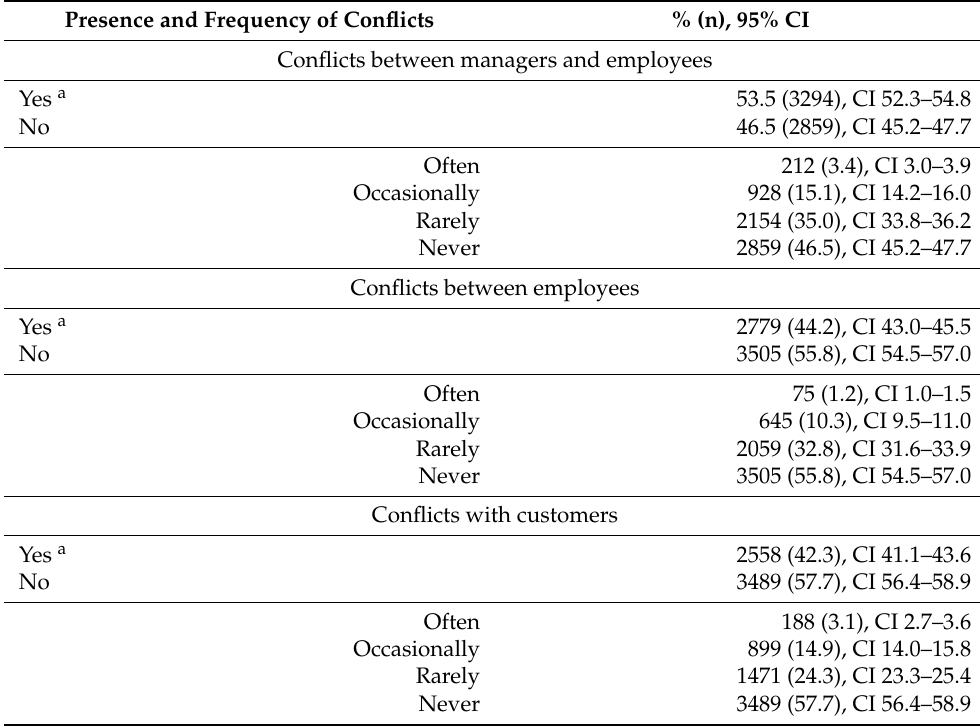
Table A1. The distribution of the types of conflict in the workplace in the study sample, n (%). Presence and Frequency of